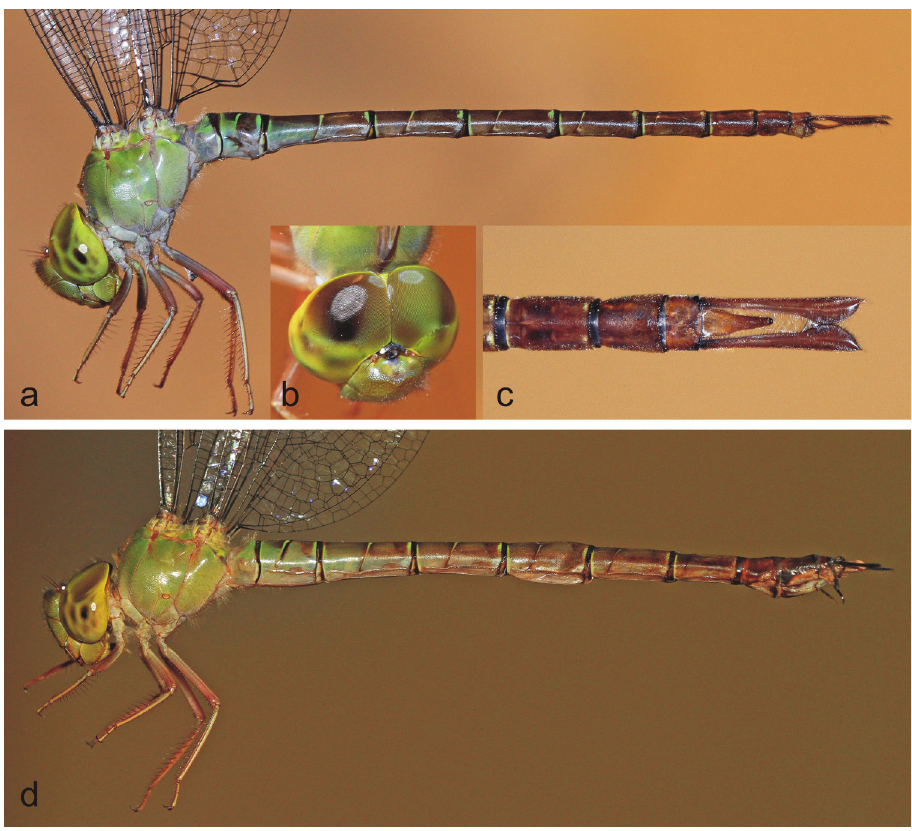
Figure 5. Gynacantha immaculifrons from Chingombe, Zambia: a male b head with a diagnostic almost unmarked postfrons c male appendages in dorsal view d female (phot. B.